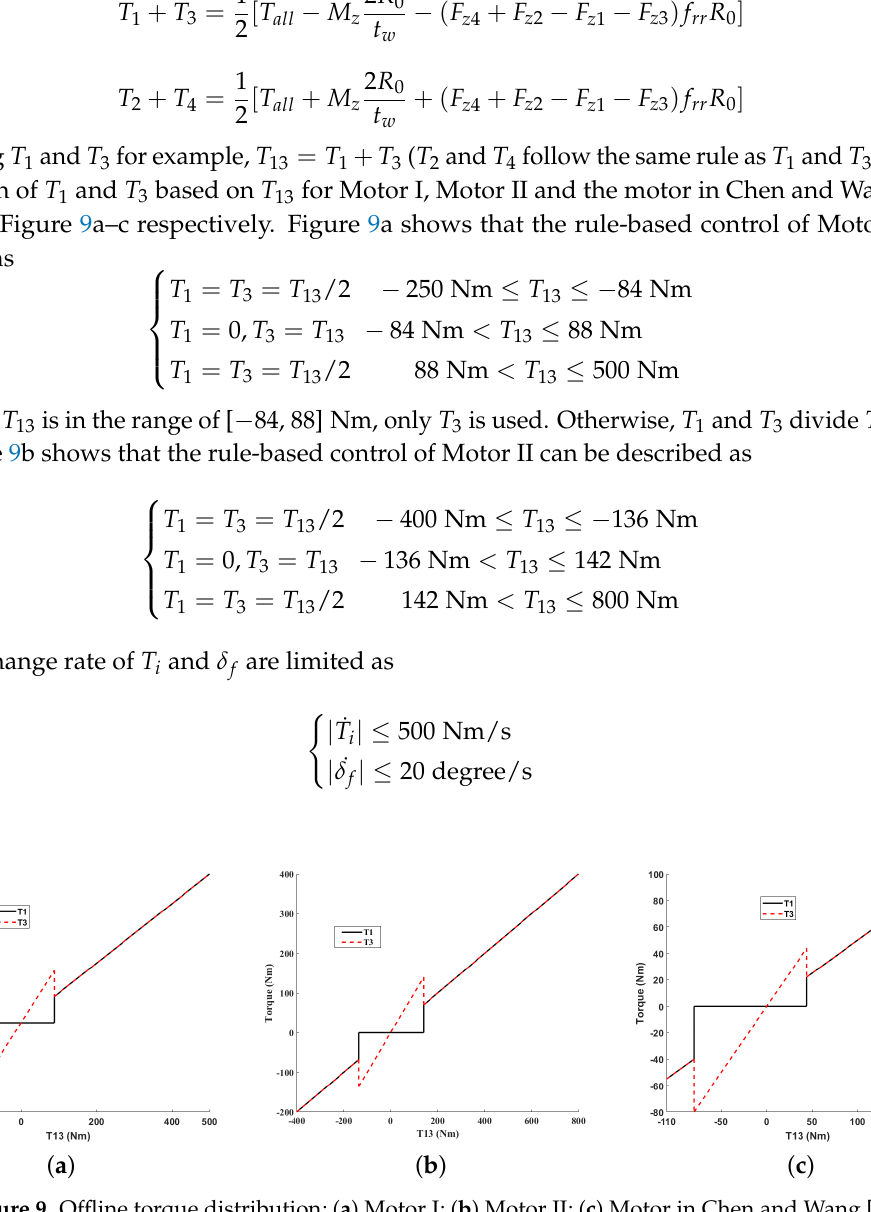
Figure 9. Offline torque distribution; ( a ) Motor I; ( b ) Motor II; ( c ) Motor in Chen and Wang